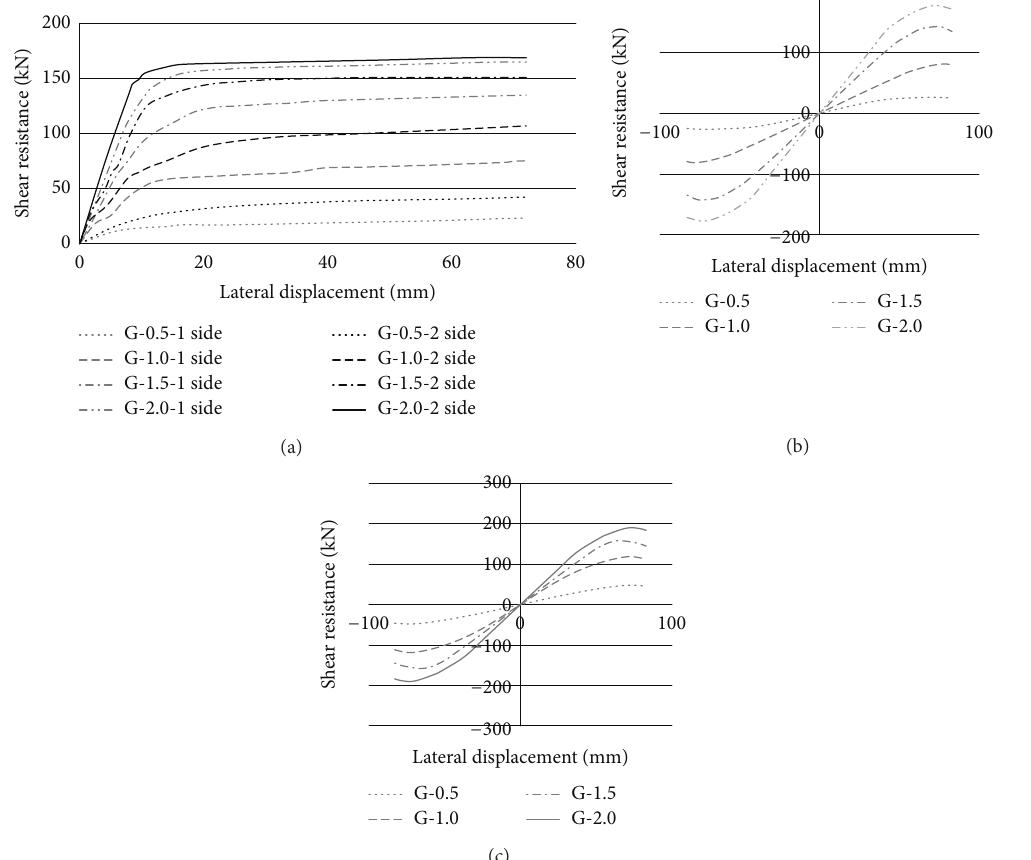
Figure 9: Curves of specimens G. (a) Monotonic curves. (b) Hysteretic envelope curves 1-side. (c) Hysteretic envelope curves 2-side.